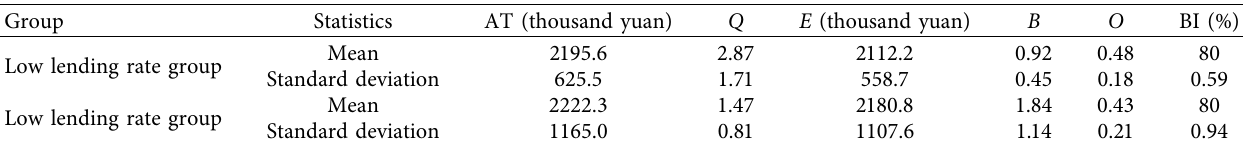
Table 9: Descriptive statistics of lending rate